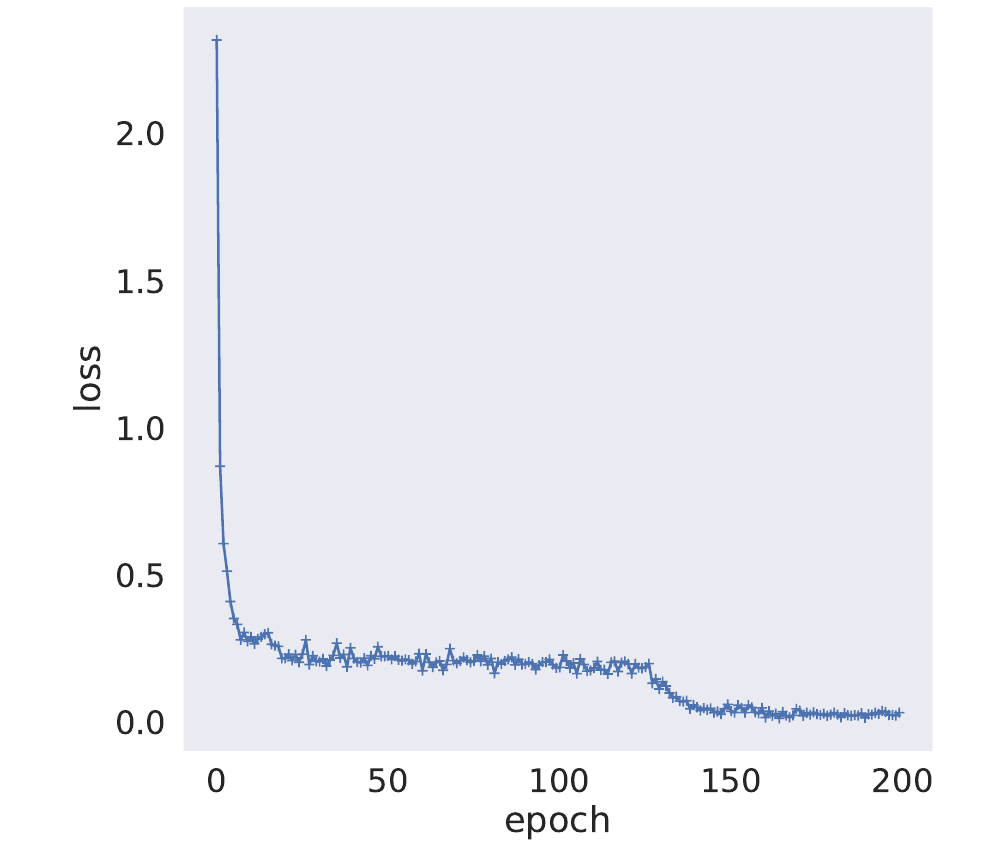
Figure 5. The loss curve of the TSMASAM model. Table 1. Comparative experiment between TSMASAM and the machine learning-based anomaly detection algorithm.